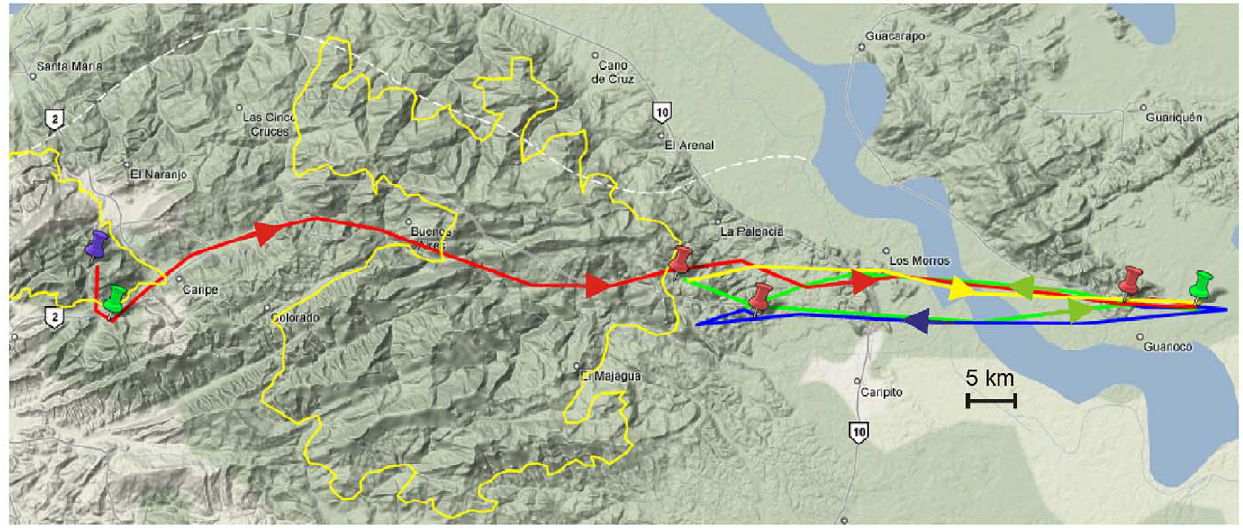
Figure 1. GPS locations for bird tagged with logger number 25. Roosting and foraging sites are indicated by markers. Green markers are foraging sites and red are roosting sites. The blue marker is the Cueva del Gua´charo. Days of travel are indicated by colour: day 1, red, day 2, blue, day 3 green, day 4 yellow. The yellow lines mark the boundaries of both sectors of the Parque Nacional el Gua´charo.